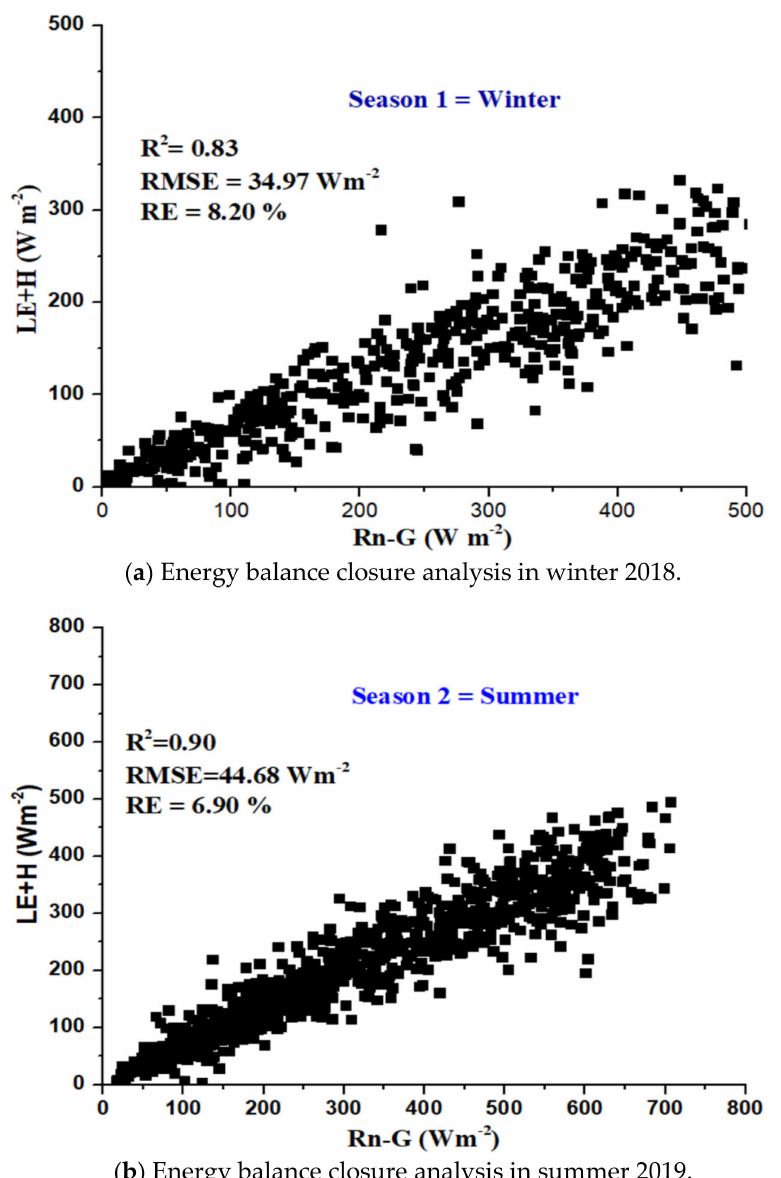
Figure 3. Energy balance closure analysis: ( a ) Season 1 in winter (DOY 290–334) 2018; ( b ) Season 2 in summer (DOY 90–175)